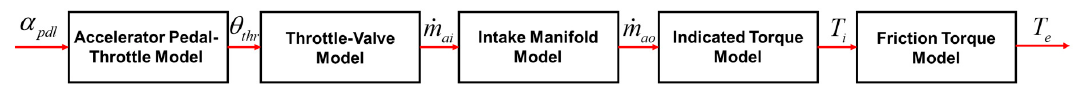
Figure 2. The model blocks of the spark ignition (SI) engine.